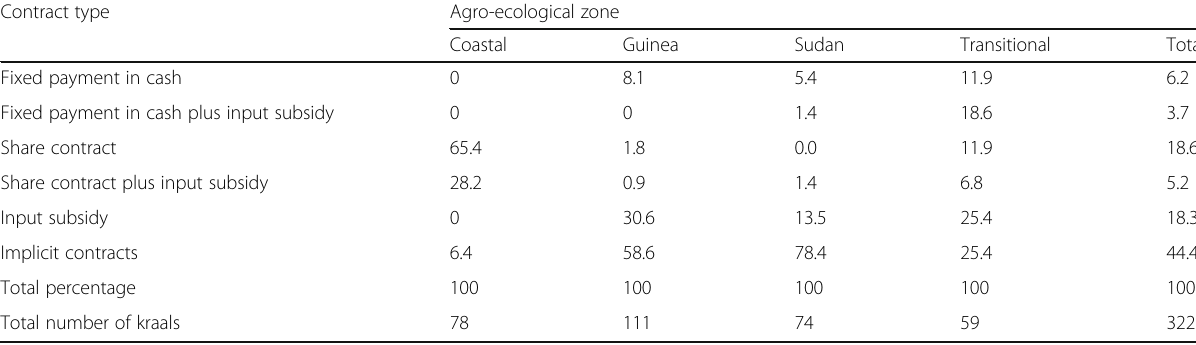
Table 1 Distribution (percentage) of cattle owner – kraal owner contract types by agro-ecological zone Contract type